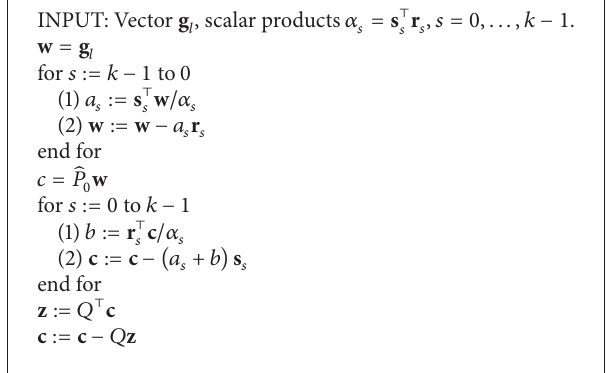
Algorithm 2: Computation of c = 𝑃 𝑘 g 𝑙 for the BFGS